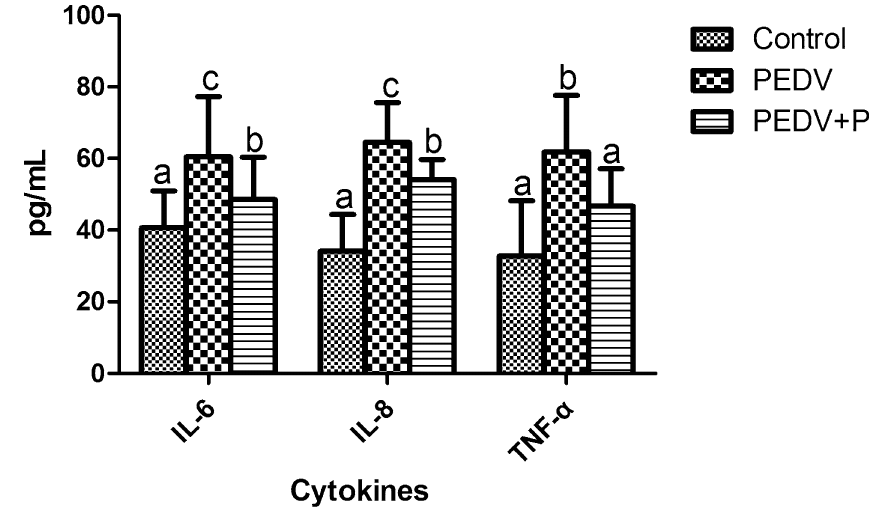
Figure 4. Effects of puerarin (PR) administration on cytokines in the plasma of piglets after PEDV infection. Values are mean and SD, n = 8. a, b, c , Values within a column not sharing a common superscript letter indicate significant difference at P < 0.05.